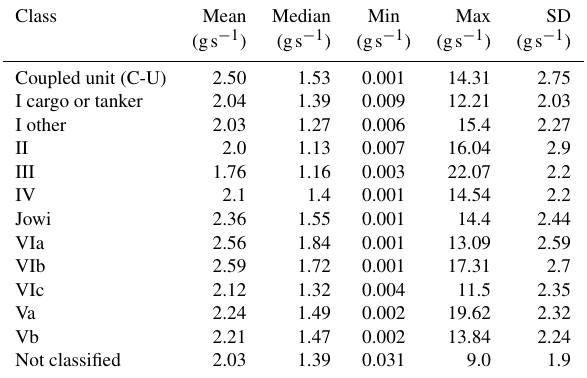
Table B1. Summary of data shown in Fig. 11. NO x emission rates for ships entering NERH are shown.